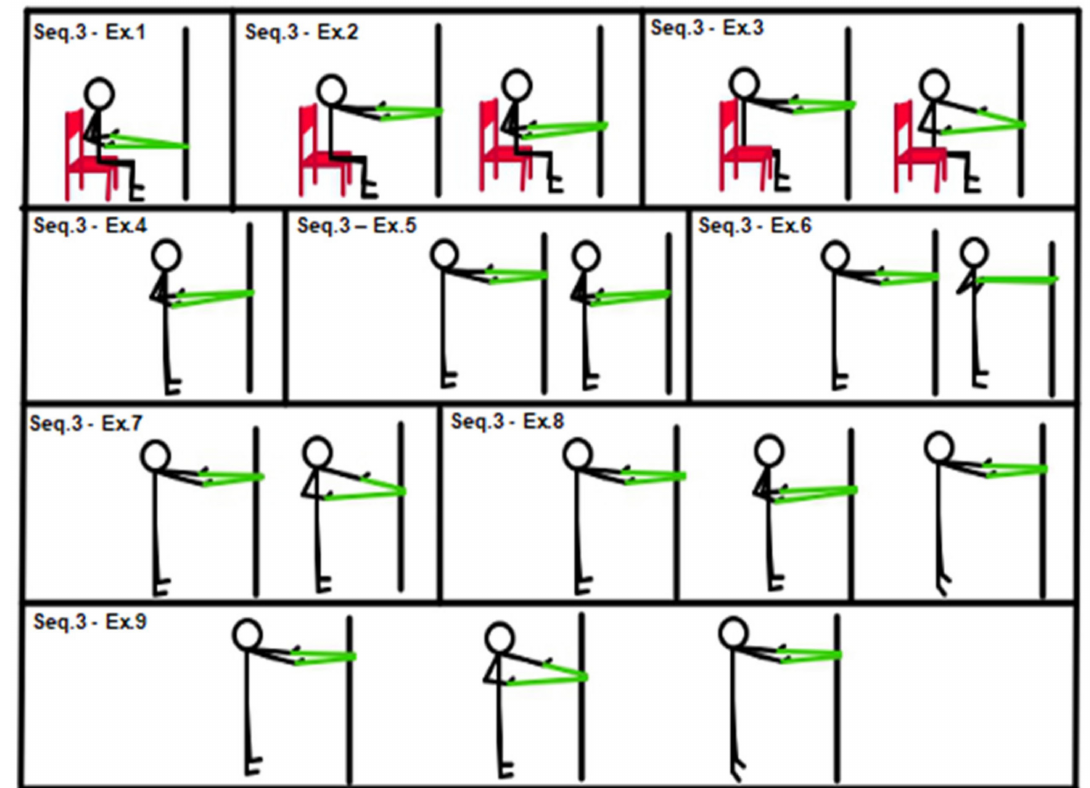
Figure 3. Sequence 3: upper limbs, entry